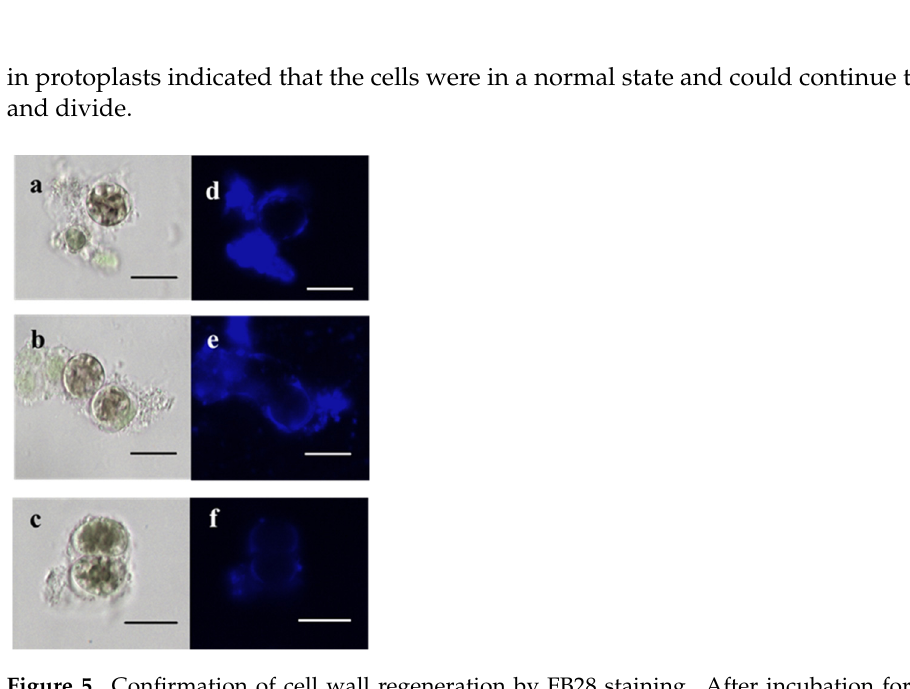
Figure 5. Confirmation of cell wall regeneration by FB28 staining. After incubation for 2 days, protoplasts ( a – c ) were stained with FB 28. The presence of regenerated cell wall (in blue) was confirmed under UV florescence microscope ( d – f ). Scale bars = 20 µm.